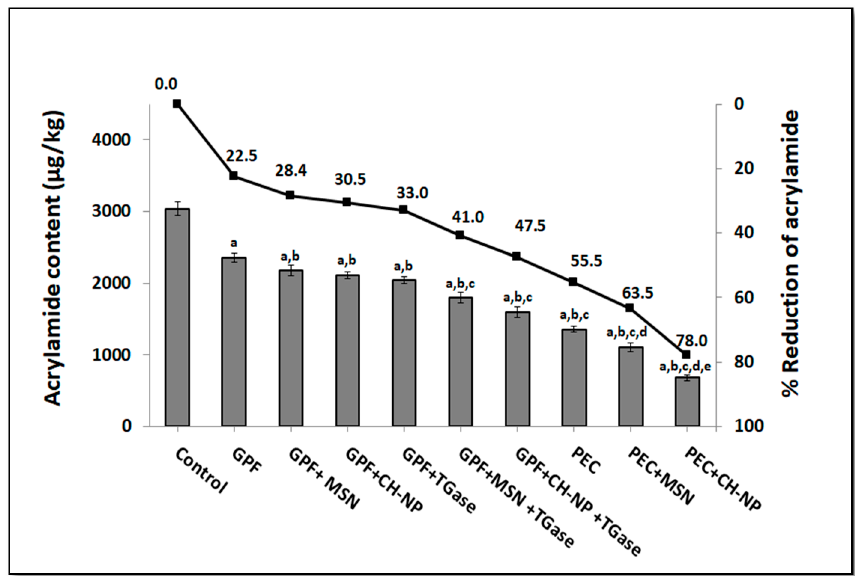
Figure 2. Influence of di ff erent hydrocolloid coatings on acrylamide content of fried kobbah (y-axis on the left based on fat-free dry matters (FFDM)) and% acrylamide reduction (y-axis on the right). “Control” represents kobbah sample dipped in distilled water. Columns “a” indicate values significantly di ff erent from the control sample; columns “b” indicate values significantly di ff erent from grass pea flour (GPF)-coated kobbah; columns “c” indicate values significantly di ff erent from GPF + mesoporous silica nanoparticles (MSN)-coated kobbah or GPF + transglutaminase (TGase)-coated kobbah; columns “d” indicate values significantly di ff erent from PEC-coated kobbah; columns “e” indicate values significantly di ff erent from pectin (PEC) + MSN-coated kobbah. Additional details are reported in the main text.